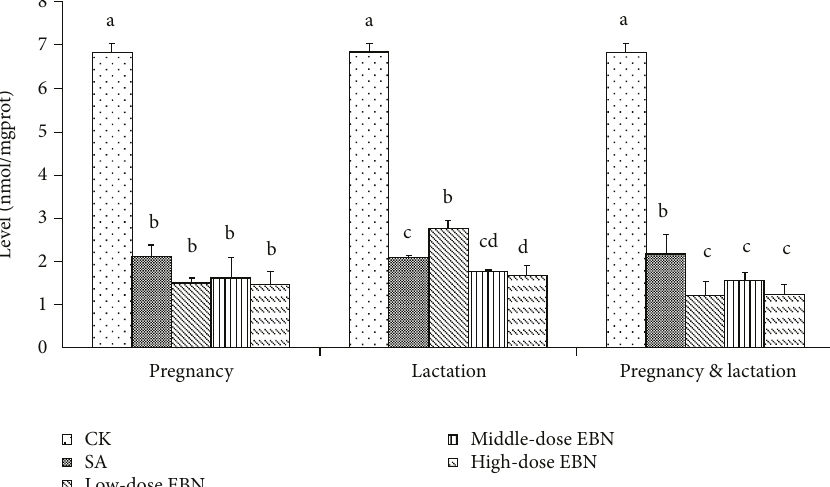
Figure 7: Comparison of malondialdehyde (MDA) activity in brain tissue among the 10 weaning cubs from each group. Signi fi cant di ff erences were indicated by di ff erent letters for each group ( P < 0 05